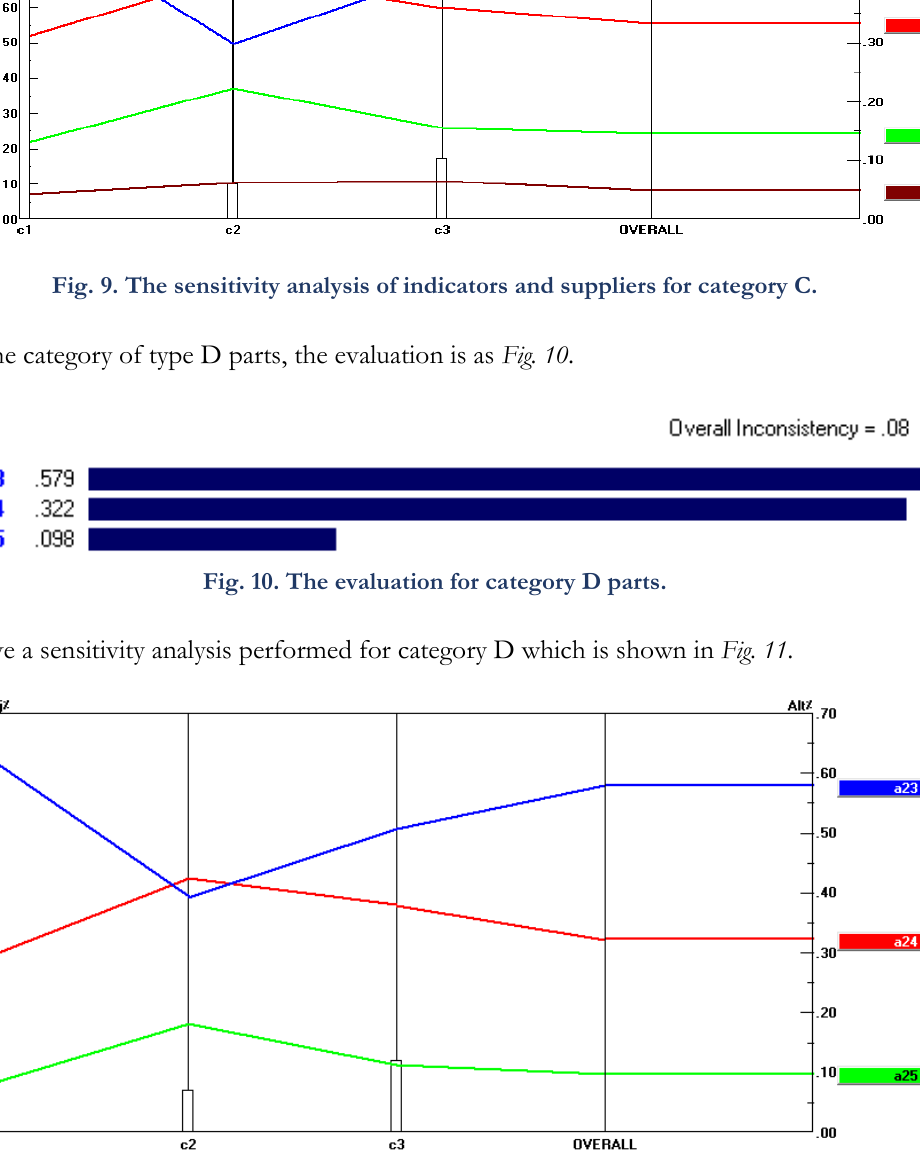
Fig. 11. The sensitivity analysis of indicators and suppliers for category